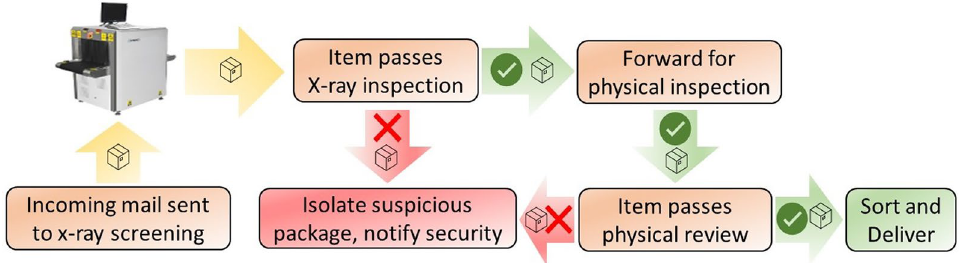
Figure 1. The current screening process followed by most mail services, which does not rely on any quantitative information.